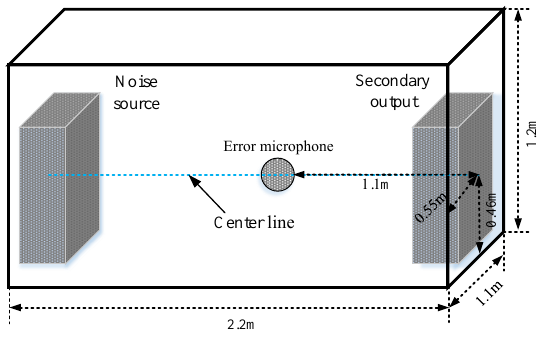
Figure 5. Position diagram of error